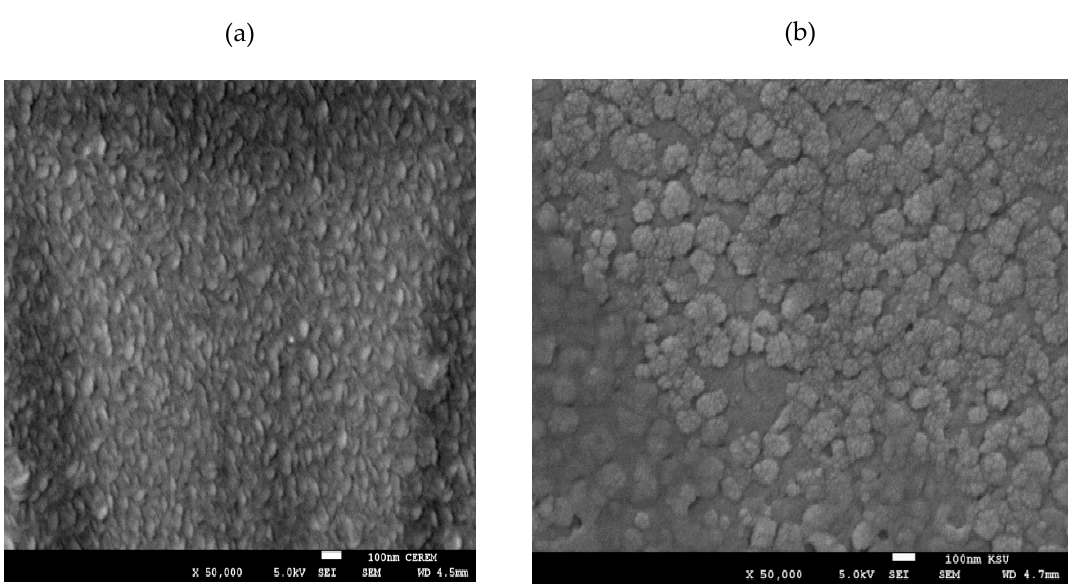
Figure 7. Scanning electron micrographs (SEM) micrographs ( a ) HSNP-2 and ( b ) HSNP-1.